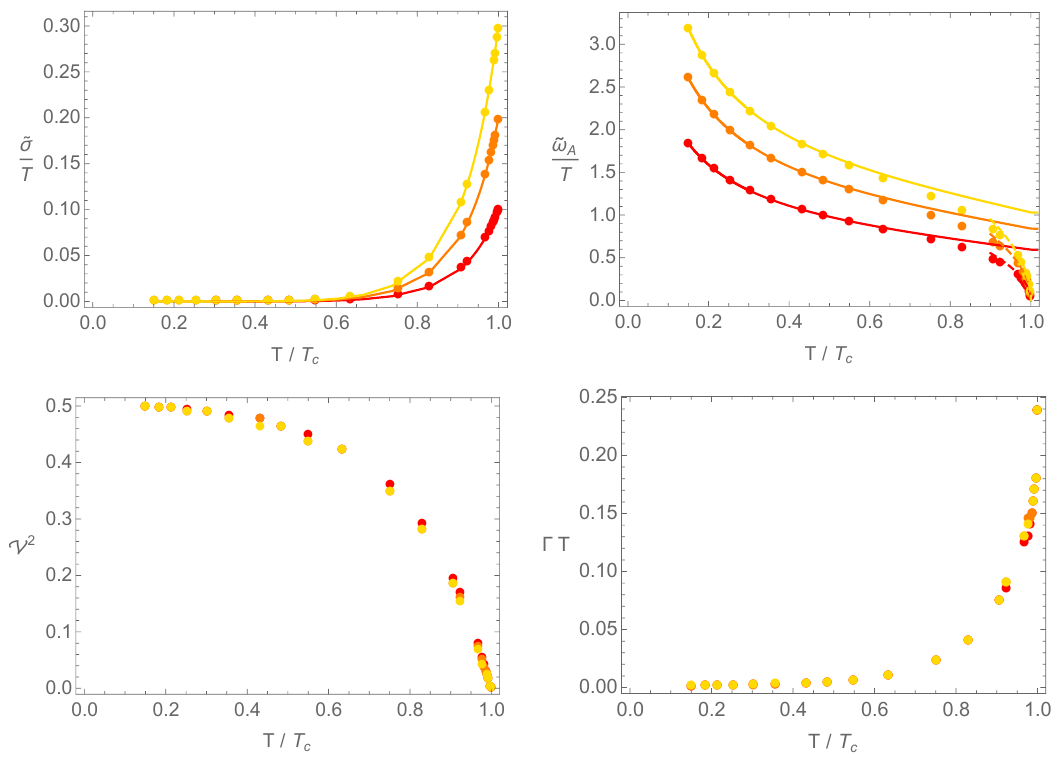
Figure 13 . Coefficients appearing in the dispersion relation (6.2) as a function of the reduce temperature for λ = 0 . 1 , 0 . 2 , 0 . 3 (red, orange, yellow). Solid lines represent eq. (5.9) for ˜ σ and eq. (5.11) for ˜ ω . The dashed lines are eq. A